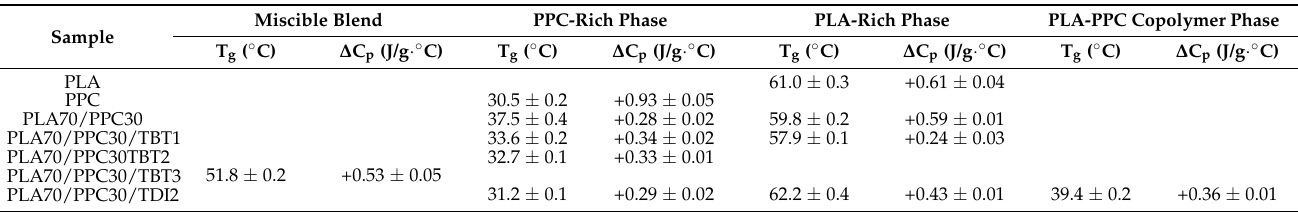
Figure 3. DSC heating thermograms of the studied samples at a rate of 10 ◦ C/min (the samples were first heated to 200 ◦ C and held for 5 min, and then cooled down to room temperature at a rate of 10 ◦ C/min). Table 3. Glass transition temperature and change in heat capacity for T g transition.